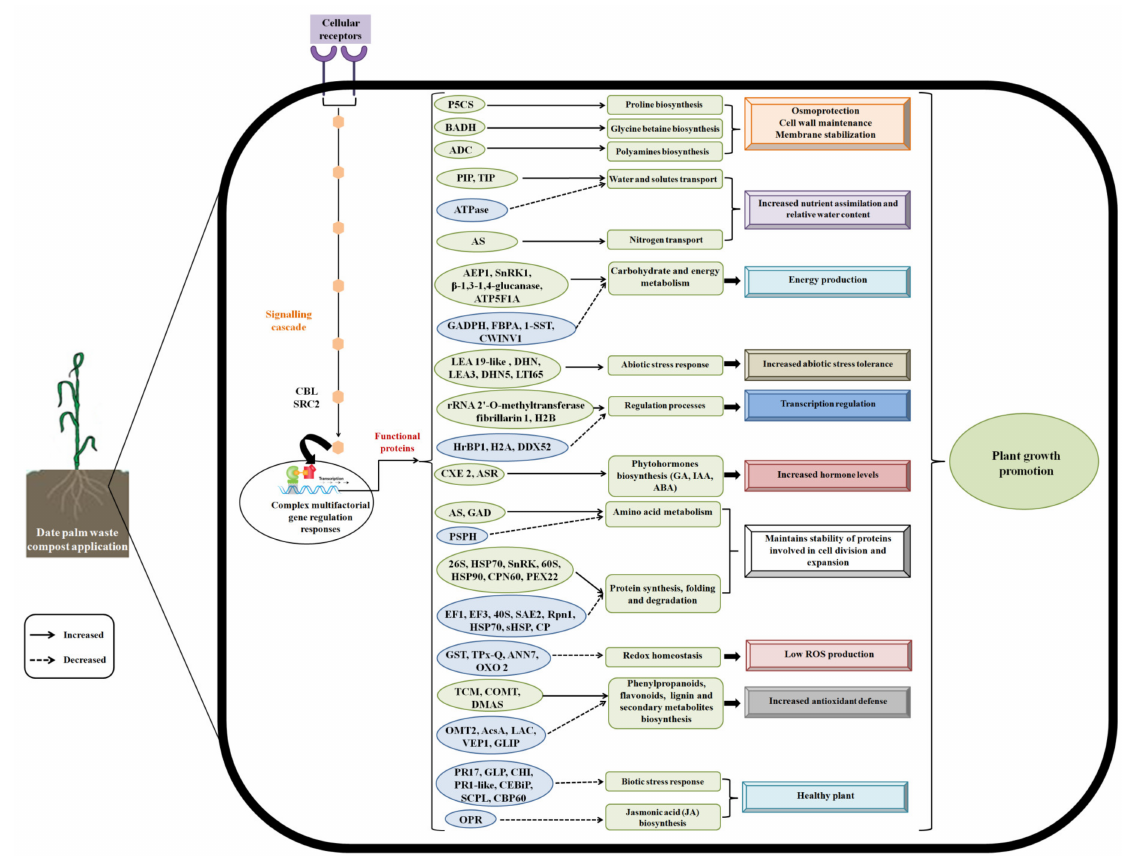
Figure 6. A model of date palm waste compost effects on barley